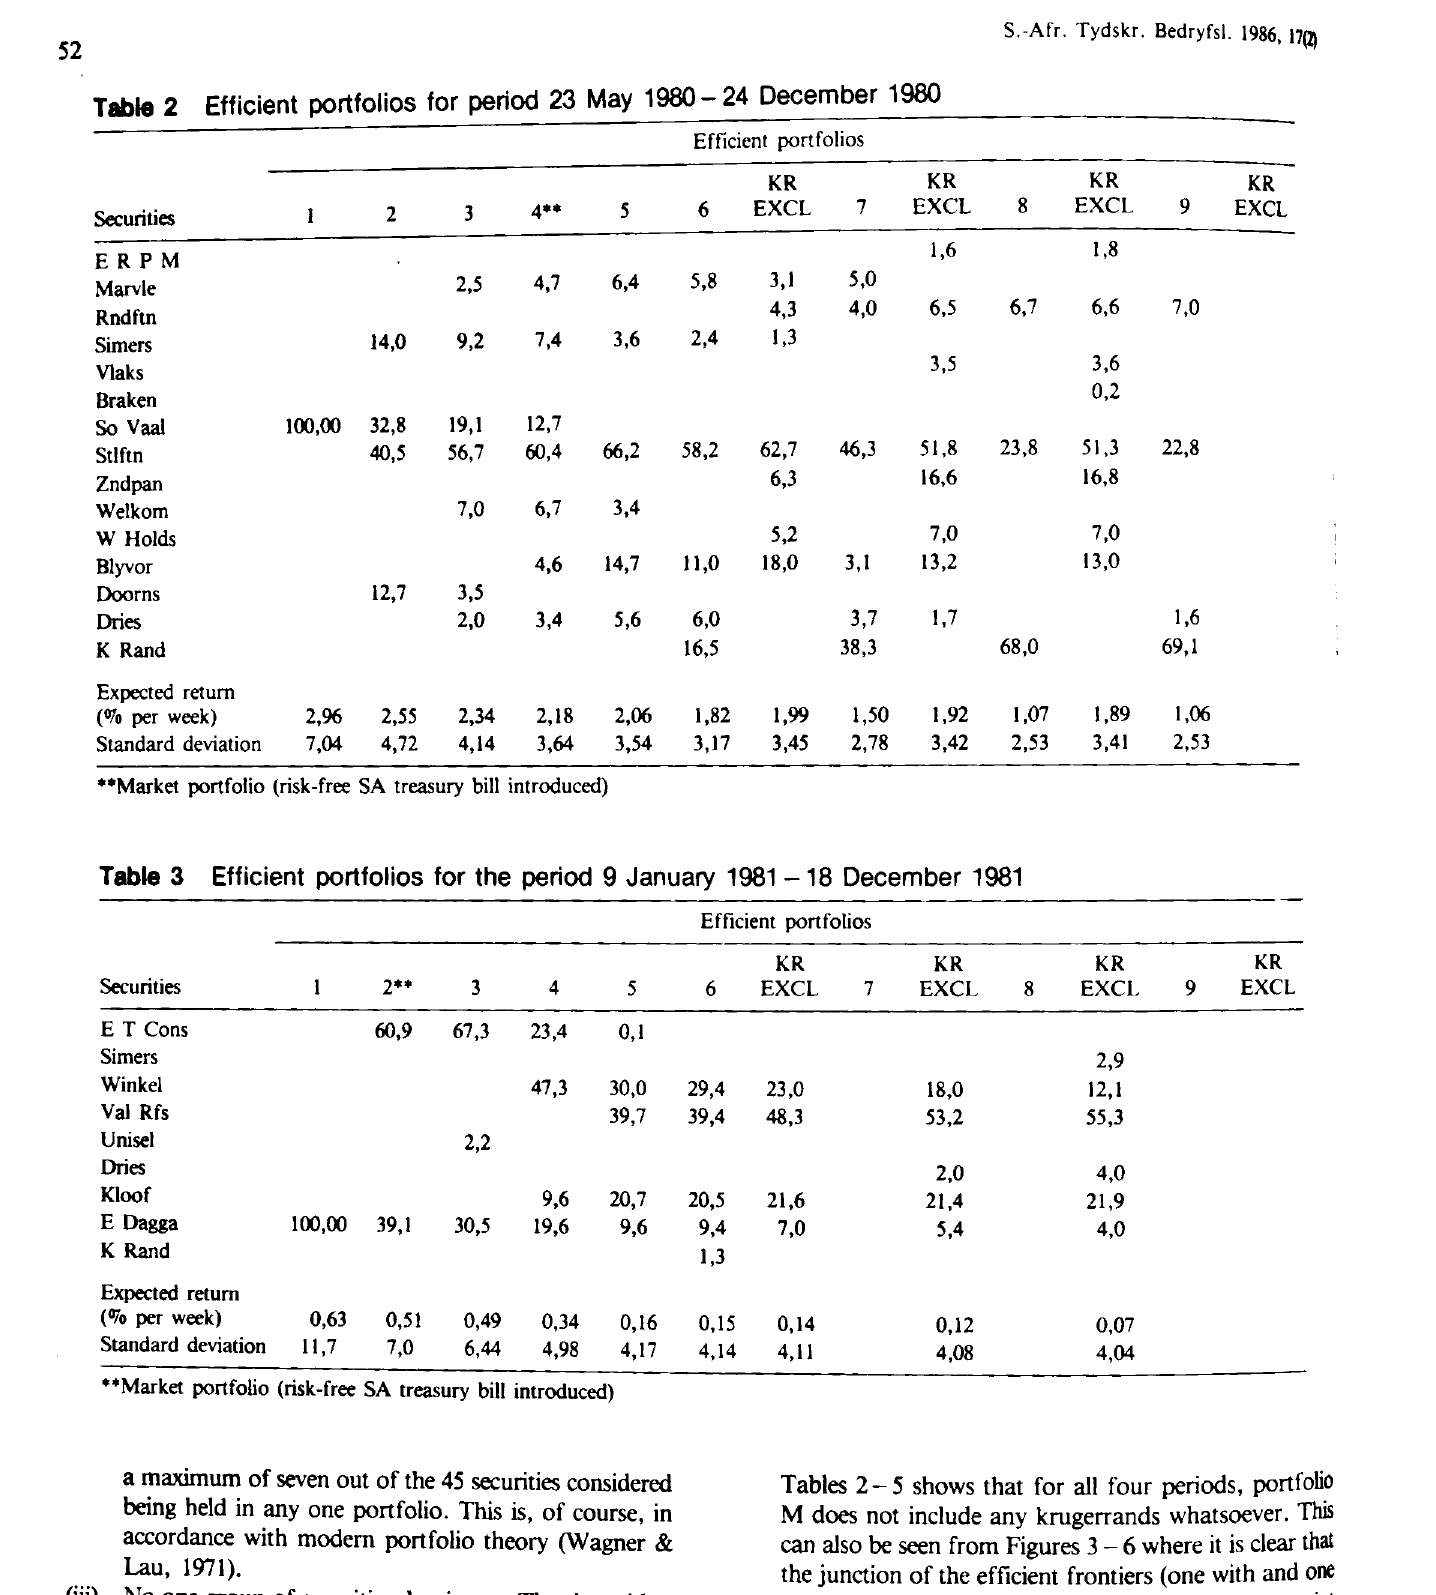
Efficient portfolios for period 23 May 1980- 24 December 1980